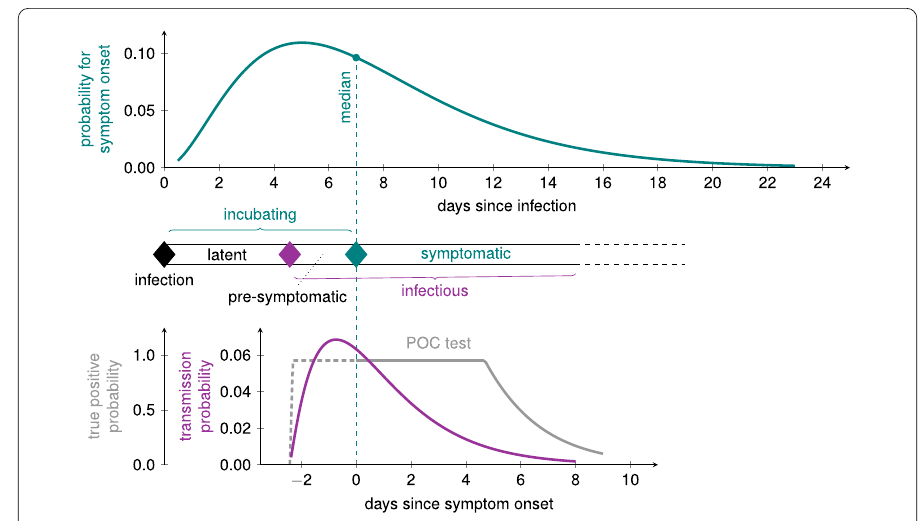
Figure 1 Course of the disease with probability distribution for the incubation period T Inc (top) [25] and the fully correlated probability density function for the contagiousness T con (bottom) [26]. The dotted vertical lines corresponds to the median of T Inc . The probability for a true–positive point-of-care (POC) test is displayed on the bottom left (grey line). The diamonds correspond to exposure (contact, black), end